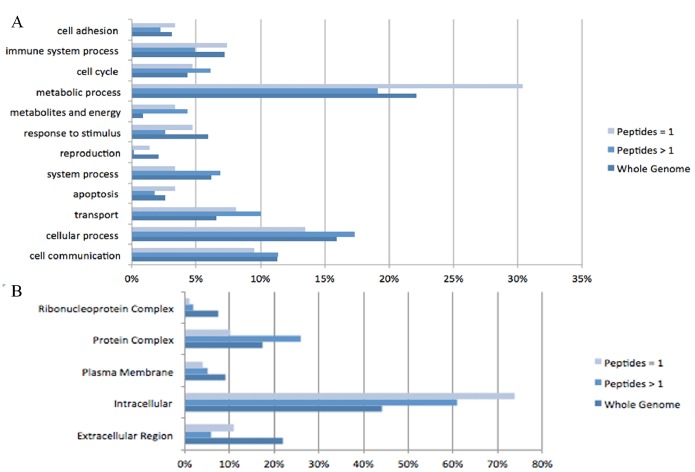
Functional distribution (A) and Sub-cellular distribution (B) of proteins identified with 1 peptide and 2 or more peptides compared to the entire Rattus norvegicus genome.Functional and spacial categories are those defined in the PANTHER database.